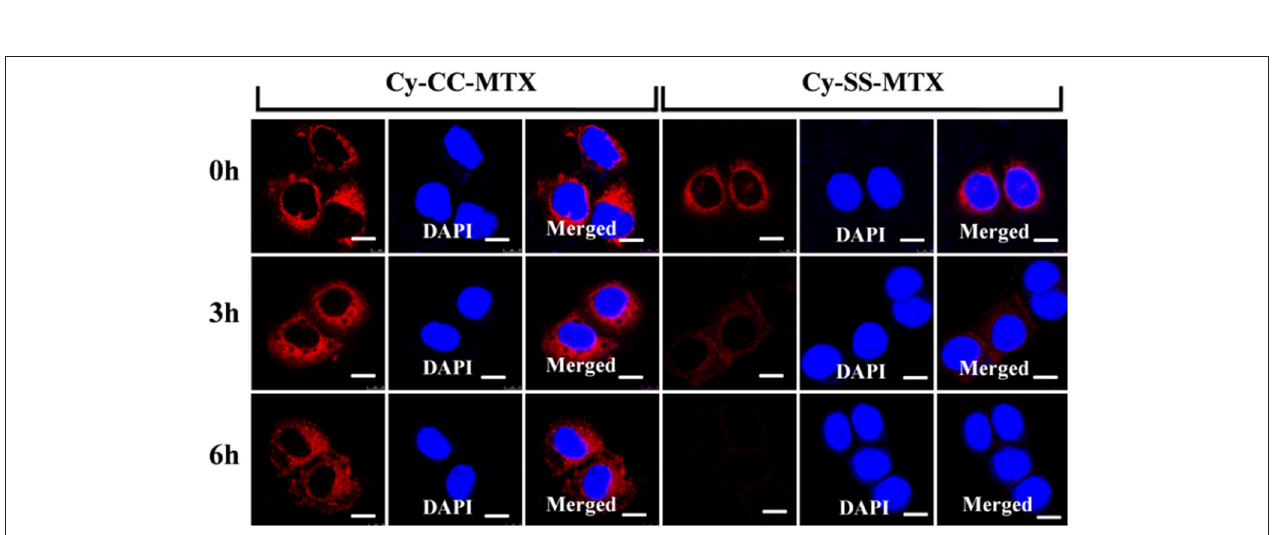
FIGURE 5 | Time-dependent Fluorescence confocal microscope images of MCF-7 cancer cells for tracking the activation of prodrug Cy-SS-MTX. Images were obtained at 0/3/6h after cultivating Cy-SS-MTX or CY-CC-MTX (5 µ M) with cells for 30min. ( λ ex = 633nm for Cy-SS-MTX/Cy-CC-MTX and λ ex = 405nm for DAPI). Scale bar, 10 µ